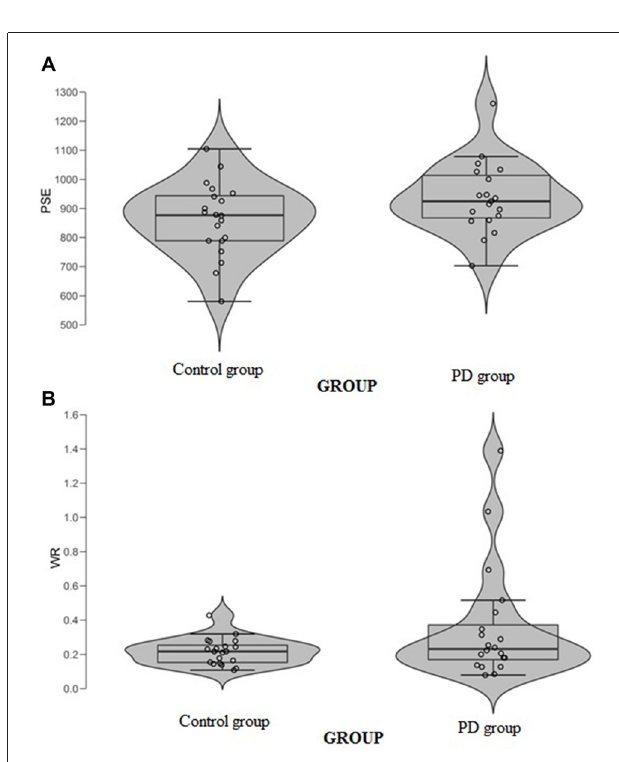
FIGURE 3 | (A) Point of subjective equality (PSE) and (B) Weber Ratio (WR) of the time bisection task as a function of groups. Each dot represents a single participant.